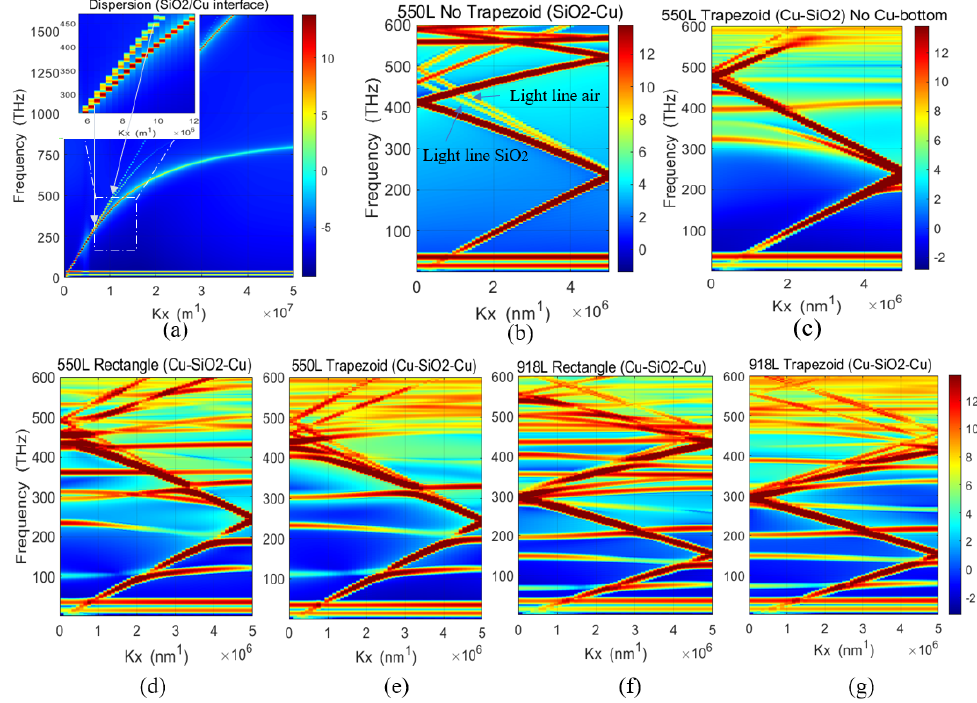
Figure 4. ( a ) The dispersion relationship of the SiO 2 -Cu layer interface; ( b ) the band structure of the periodic layer of the 550L trapezoid without the Cu trapezoid; ( c ) the band structure of the periodic layer of the 550L trapezoid without the Cu bottom layer; ( d ) the band structures of the periodic layers of the 550L rectangle and ( e ) trapezoid; ( f ) the band structures of the periodic layers of the 918L rectangle and ( g ) trapezoid.